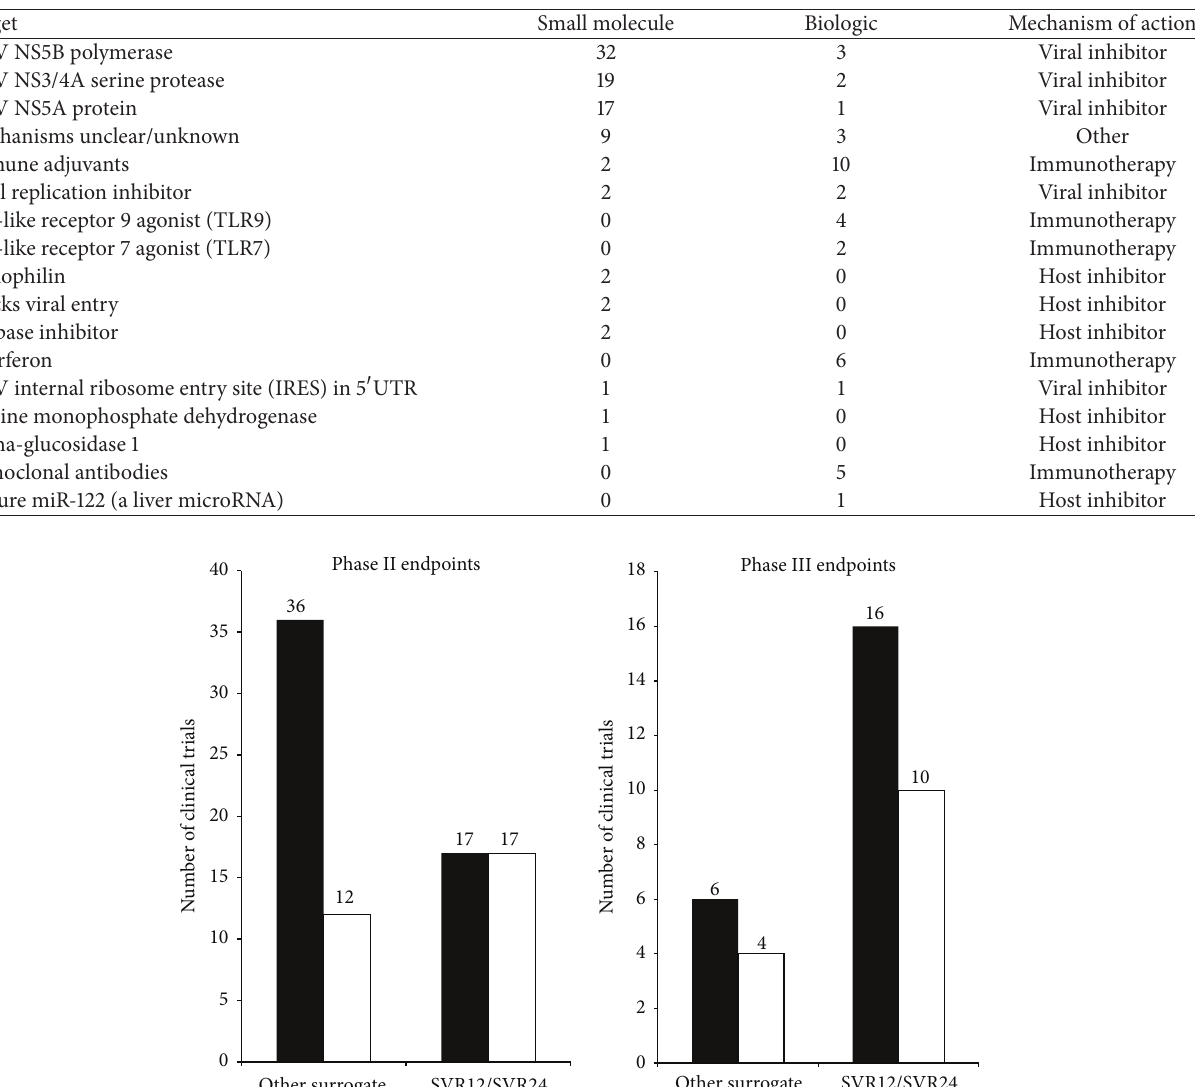
Table 1: The number of small molecule and biologic drugs associated with known molecular targets.